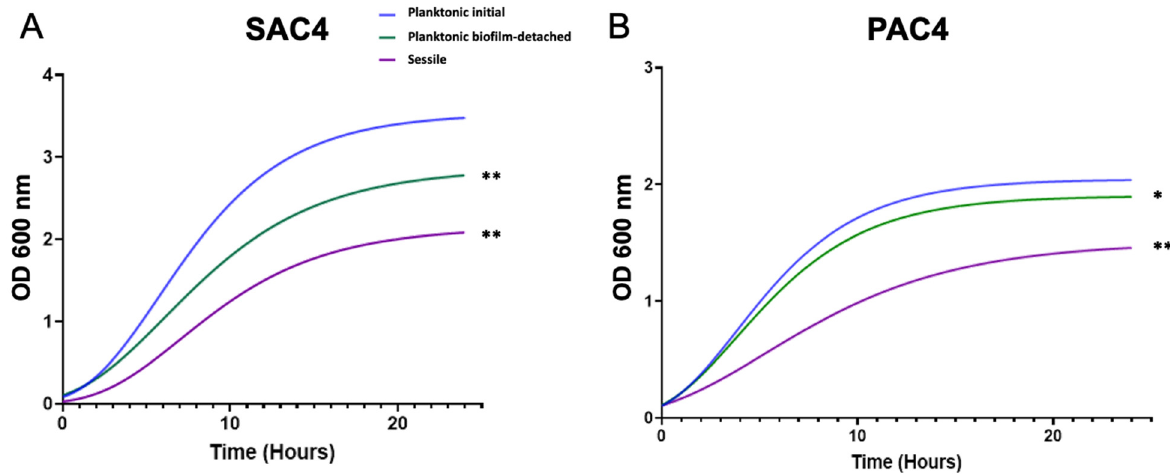
Figure 3. Growth curves of the clinical S. aureus strain SAC4 ( A ) and P. aeruginosa strain PAC4 ( B ) cultivated in CWM. Planktonic initial cells are represented in blue, sessile cells in purple, and planktonic biofilm-detached bacteria in green. Cultures were sampled every hour for 24-h and measurements of the OD 600 were performed. Experiments were performed in three biological replicates. Results are presented as the mean of three different experiments. Statistics were performed using a t -test on GraphPad Prism version 9.2 to compare planktonic released and sessile cells compared to initial bacteria. * p < 0.1; ** p < 0.01.